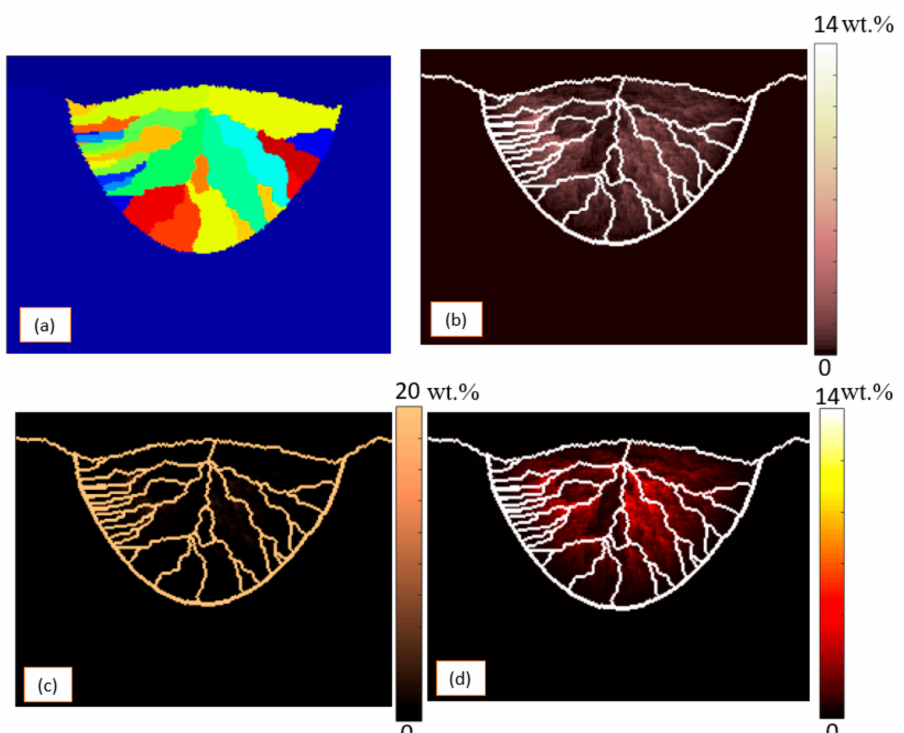
Figure 4. Simulation results for solidification behavior at 210 J/m. ( a ) Grain structure inside the track; ( b ) Nb concentration after laser melting; ( c ) Ti concentration after laser melting; ( d ) C concentration after laser